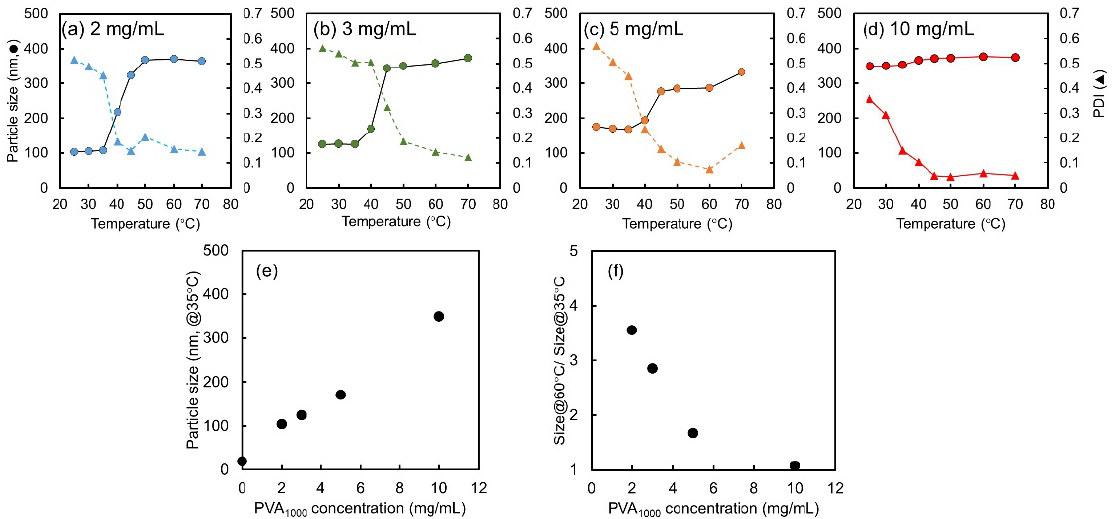
Figure 3. Average particle sizes (circles) and polydispersity index (PDI, triangles) ( a – d ) of PG 1000 particles at various temperatures, where PG 1000 particles were prepared with 2 ( a ), 3 ( b ), 5 ( c ), and 10 mg/mL ( d ) of PVA 1000 concentrations. Average particle size (at 30 °C) ( e ) and size ratio (at 60 °C vs. at 30 °C) ( f ) of PG 1000 at various PVA concentrations.